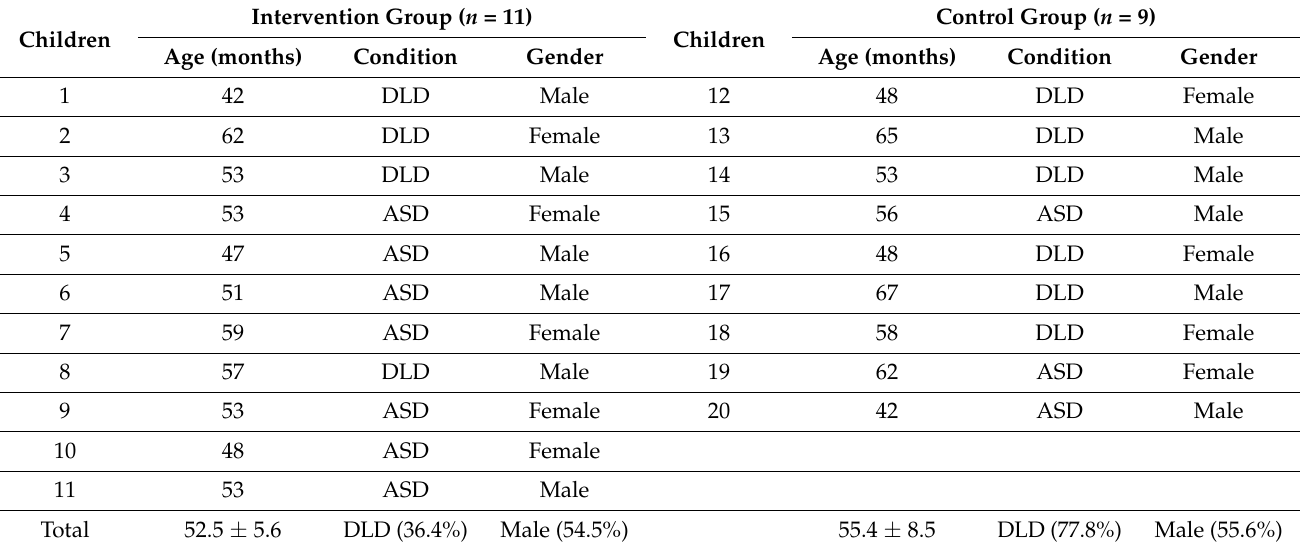
Table 1. Sociodemographic characterization.